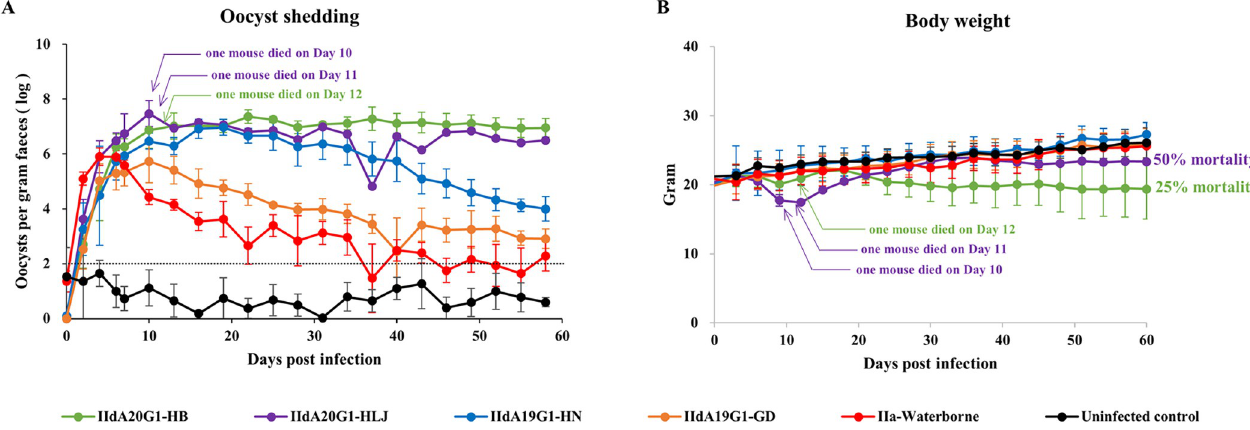
Fig 2. Virulence differed among Cryptosporidium parvum IId isolates. (A) Oocyst shedding patterns of interferon- γ -knockout (GKO) mice infected with four IId isolates and the reference IIa-Waterborne isolate. The detection threshold is indicated with a dotted line. (B) Body weight changes in GKO mice infected with four IId isolates and the IIa-Waterborne